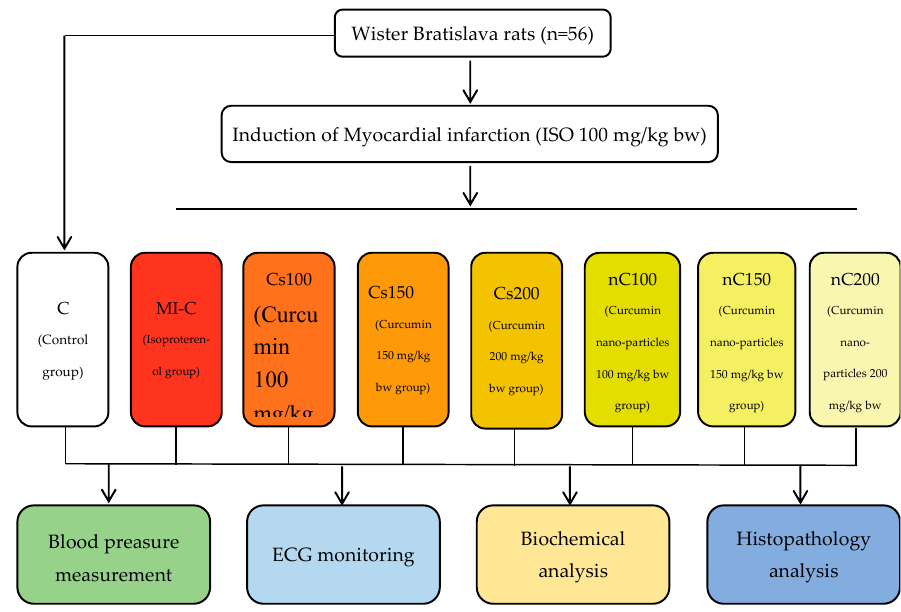
Figure 11. Flow chart demonstrating the experimental study groups.